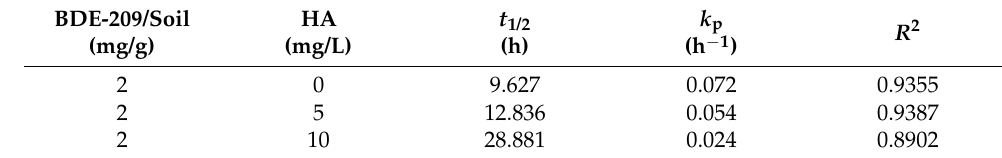
Figure 2. BDE-209 photodegradation in soil suspensions under different concentrations of HA. Table 5. BDE-209 photodegradation kinetic parameters with different concentrations of